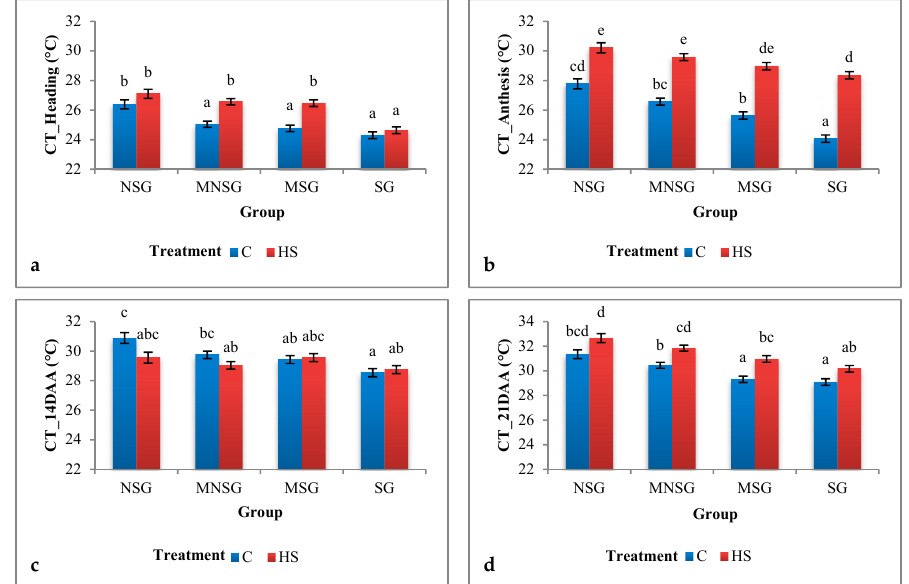
Figure 4. Variation in the canopy temperature (CT) among the non-stay-green (NSG), moderately non-stay-green (MNSG), moderately stay-green (MSG), and stay-green (SG) groups under control (C) and heat stress (HS) conditions. ( a ) Canopy temperature at heading; ( b ) canopy temperature at anthesis; ( c ) canopy temperature after 14 days of anthesis; and ( d ) canopy temperature after 21 days of anthesis. Bars represent the least square means. Error bars signify the standard errors and the di ff erent lowercase letters represent the significant di ff erences among the groups and treatments at p <